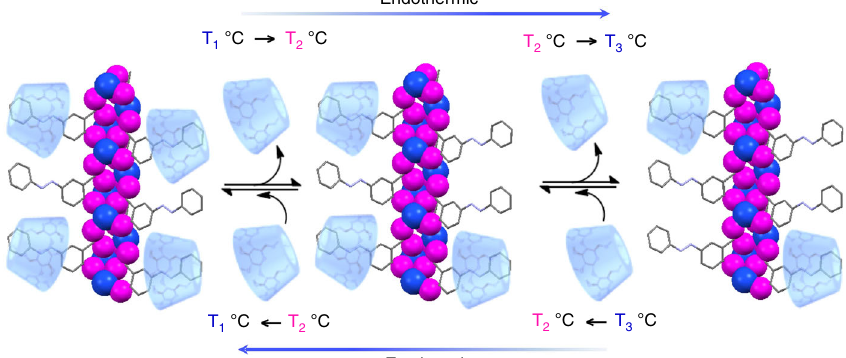
Fig. 1 Temperature-controlled host – guest systems. Schematic representation of an ideal temperature controlled formation and dissociation of multiple guests (cyclodextrins) from a host (coordination polymer) in a stepwise